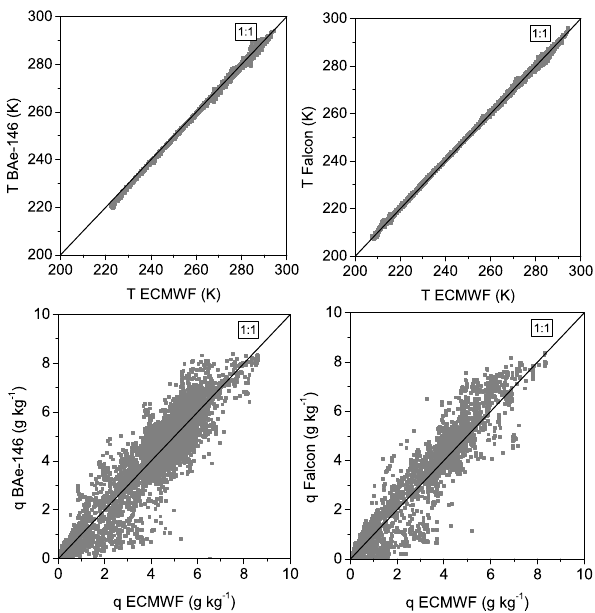
Fig. A1. Comparison of temperature T (K) (a) and specific humid- ity q (gkg − 1 ) (b) from in-situ measurements of FAAM BAe-146 (left panels) and DLR Falcon 20 (right panels) with ECMWF model analysis data. The black line denotes the 1:1 line.